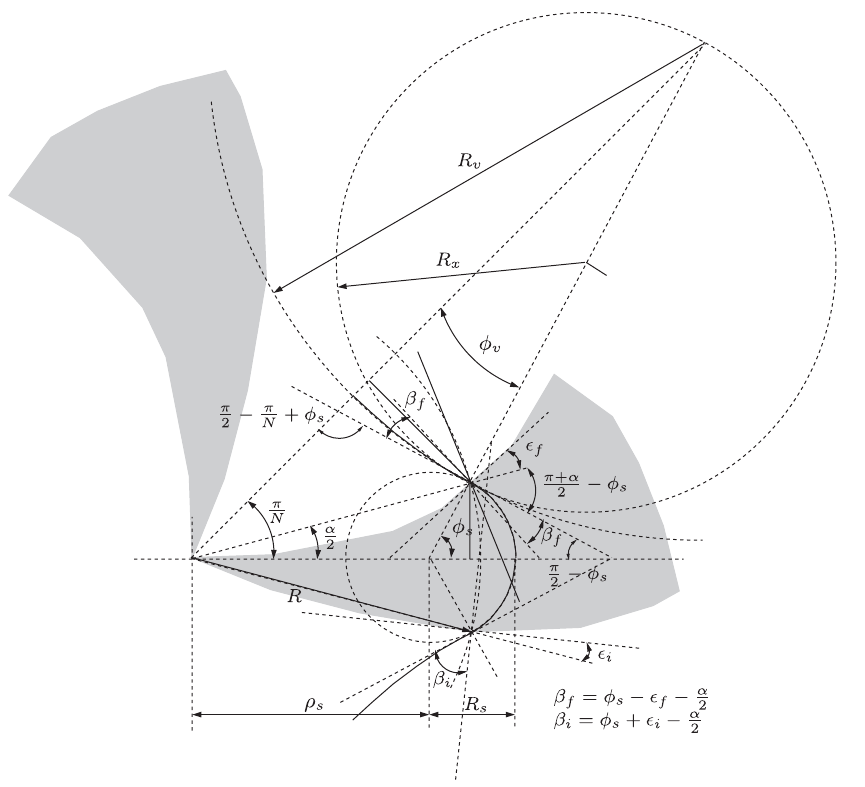
FIG. 1. Geometry of a cyclotron cell with reverse bends. The spiralled sector is indicated by a gray polygon. Since it has a constant field, the equilibrium orbit for a certain energy is composed of two arcs: Within the sector magnet it has bending radius R s and within the reverse bend (valley), it has a larger radius R v